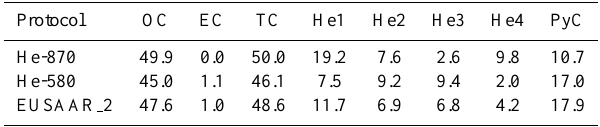
Table 2. WSOC results obtained by different protocols in µgcm − 2